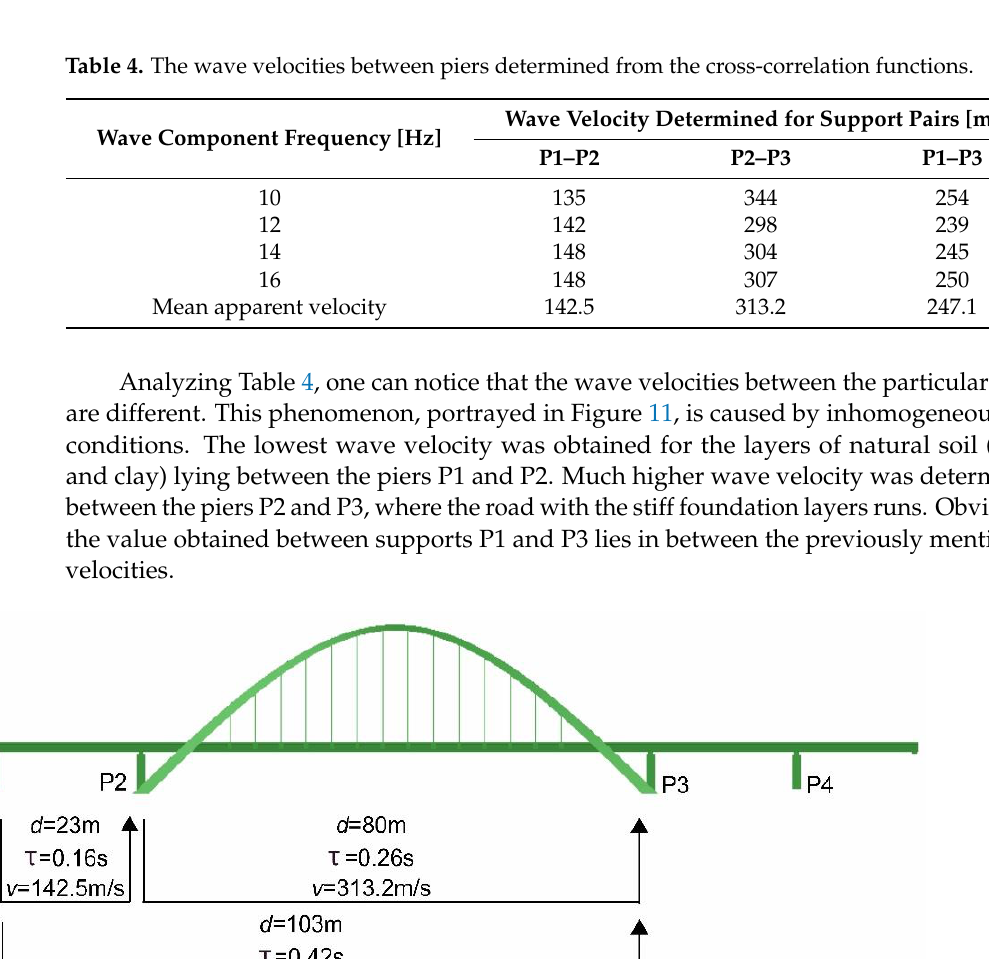
14 of 27 Figure 10. The cross-correlation functions for signal pair: ( a ) P1 – P2, ( b ) P1 – P3, ( c ) P2 – P3. As can be seen in Figure 10, the cross-correlation functions for the signal component frequency of 14 Hz reach the maximum values at 0.16, 0.42, and 0.26 sec for the pair P1 – P2, P1 – P3, and P2 – P3, respectively. Since the registered accelerations are shifted in time by the value needed for the wave front to cover the distance between the piers, the time shifts can be used to determine the apparent wave velocities between particular piers. For the known distances between piers, i.e., 23 m between P1 and P2, 103 m between P1 and P3, and 80 m between P2 and P3, the calculated wave velocities are 135, 254, and 344 m/s for the above-mentioned pairs, respectively. The mean wave velocities between particular piers (averaged over five series) are